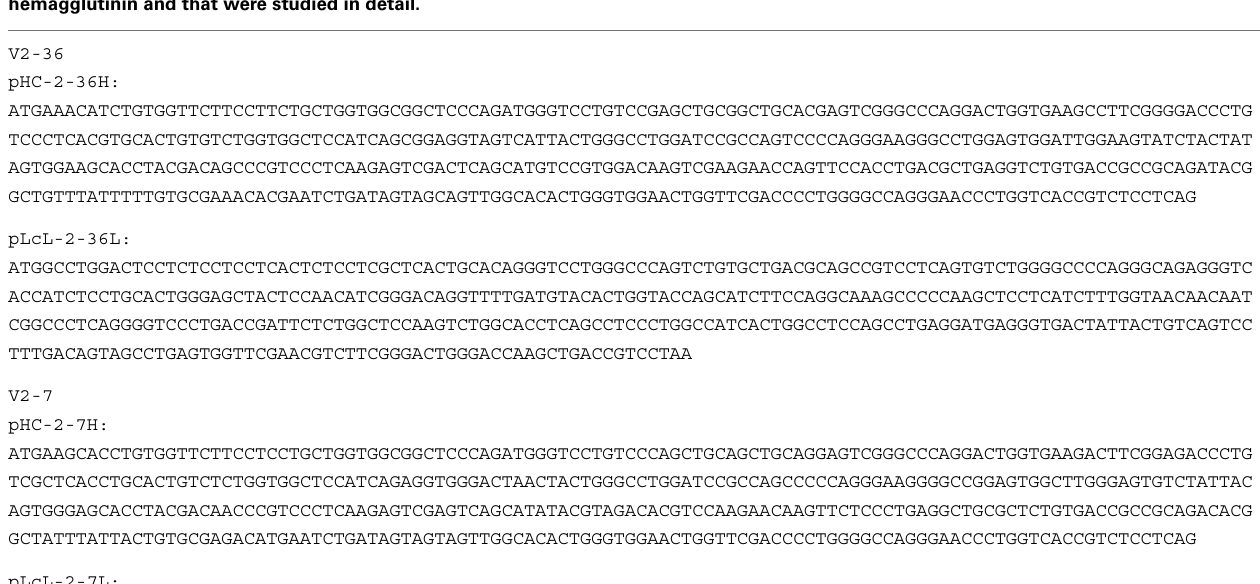
Table 2 | Nucleotide sequences of the variable regions of 10 monoclonal neutralizing antibodies that had the highest avidity for pdmH1N1 hemagglutinin and that were studied in